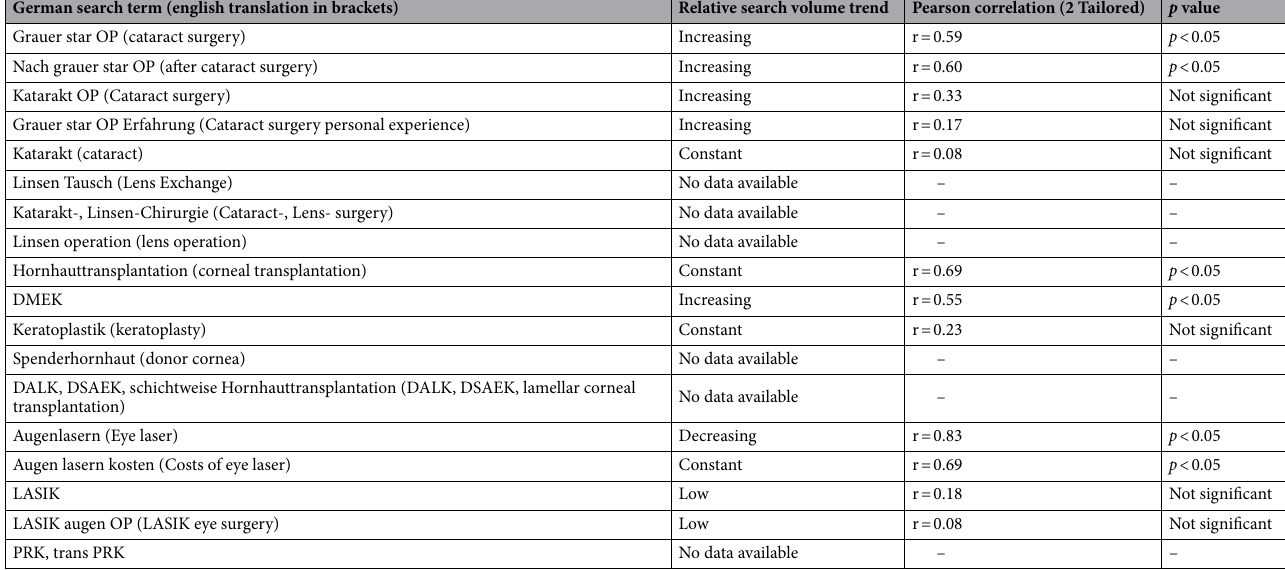
Table 1. Correlation of relative search volumes (RSV) between specific internet search terms concerning cataract surgery and corneal transplantation in Germany between March 2017 till June 2019 and